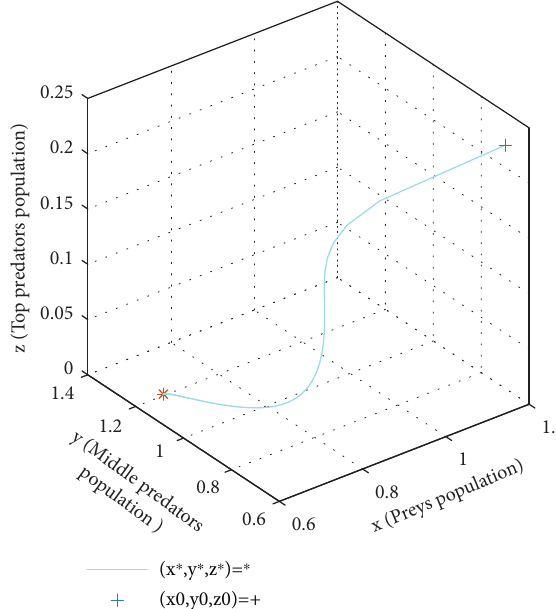
2 of the system (8).